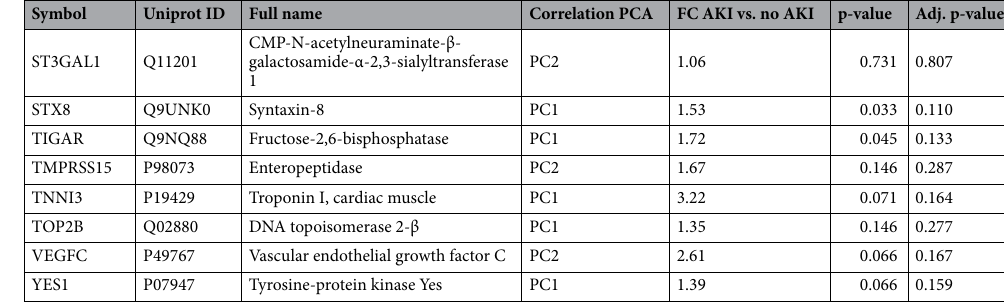
Table 3. Relative plasma levels of proteins extracted by principal component analysis. Principal component analysis revealed 38 proteins to be correlated with PC1 and 22 proteins to be associated with PC2, of which nine proteins are different between AKI as compared to non-AKI controls (bold). AKI acute kidney injury, FC fold